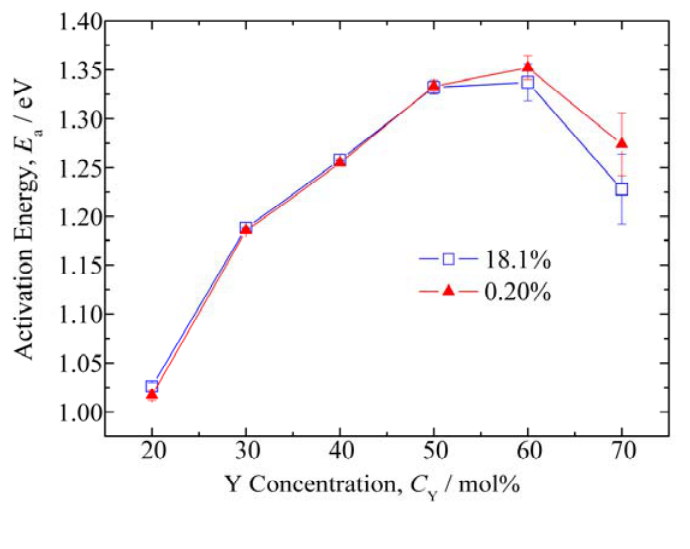
Y O ) and CeZr10 0.5 0.5 2- 